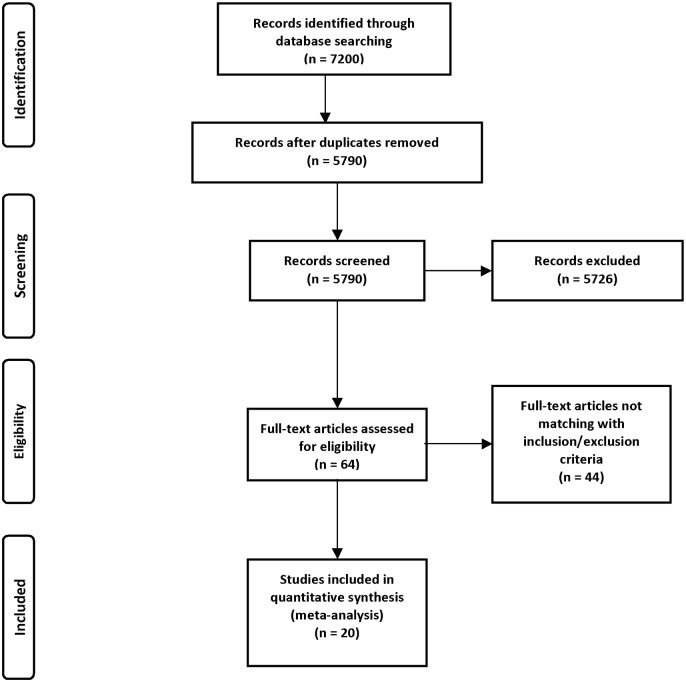
Flow diagram.Studies included in the meta-analysis.